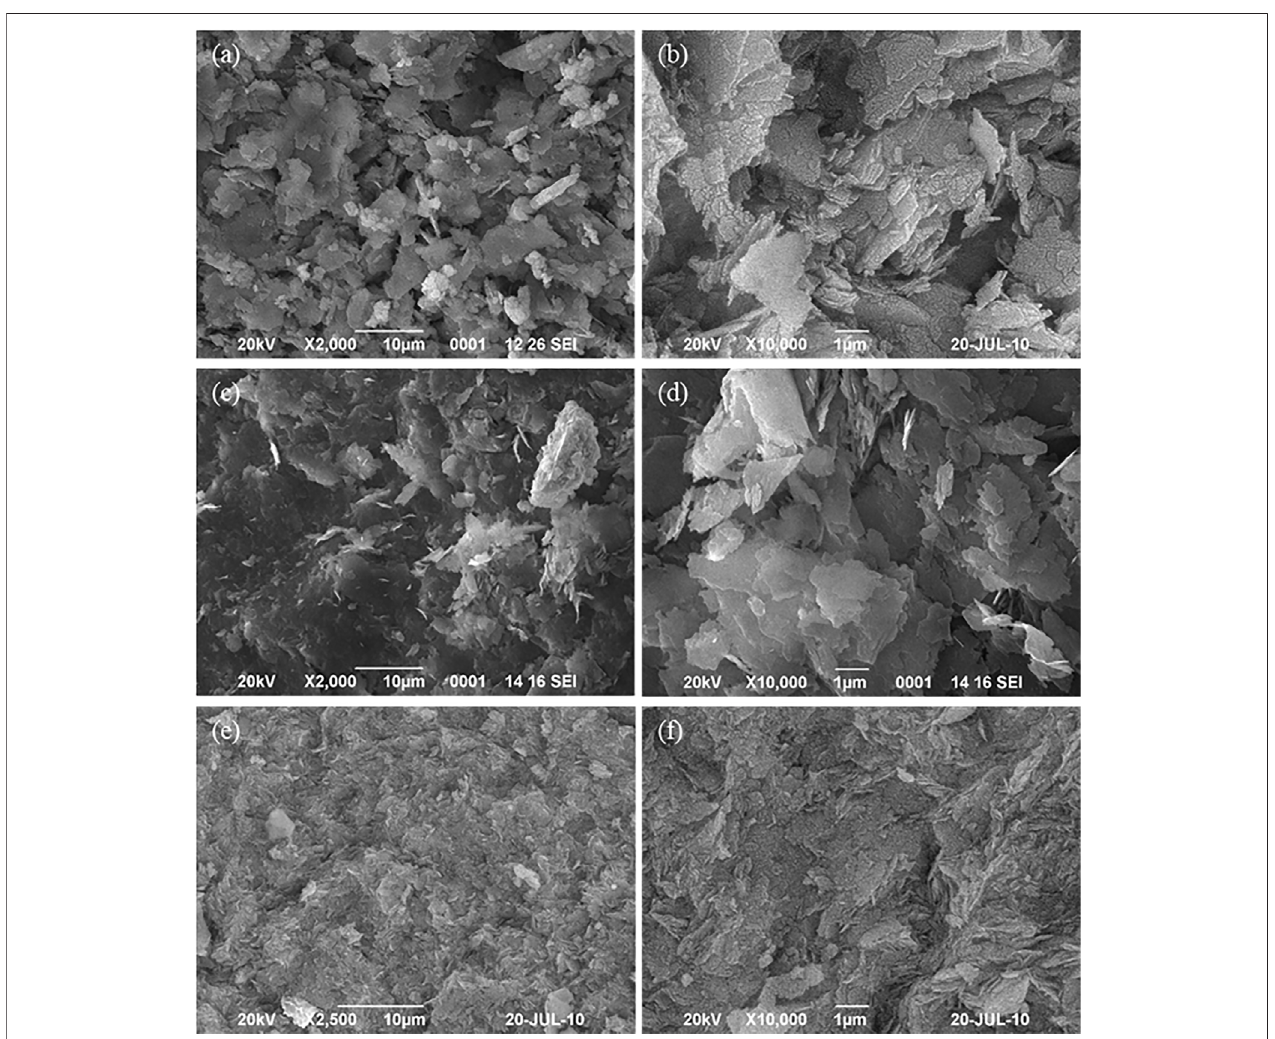
FIGURE 7 | SEM photographs for (A) (B) WSC samples; (C) (D) GCS samples and (E) (F) RC-I samples.